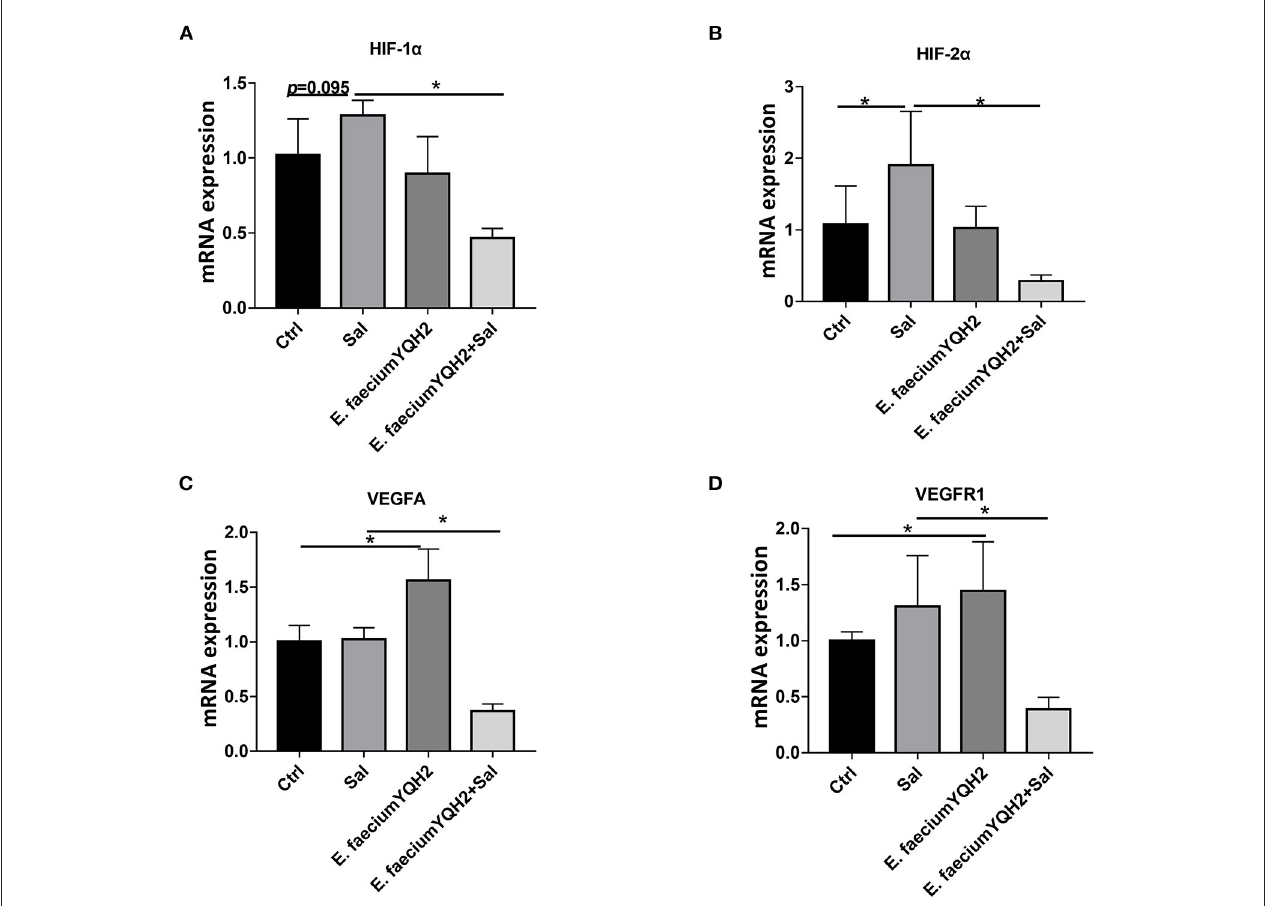
FIGURE 4 | Enterococcus faecium YQH2 inhibited the activation of hypoxia induced by S. typhimurium . (A–D) The mRNA expressions of hypoxia-related genes in ileum was detected by real-time quantitative PCR, including HIF-1 α , HIF-2 α , VEGFA, and VEGFR1, n = 8. * p <